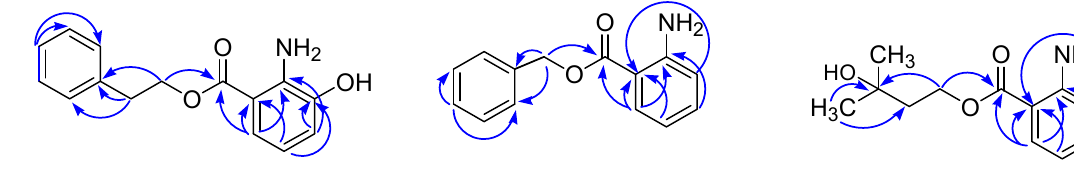
Figure 5. Selected HMBC correlations for Compounds 5 – 7 .